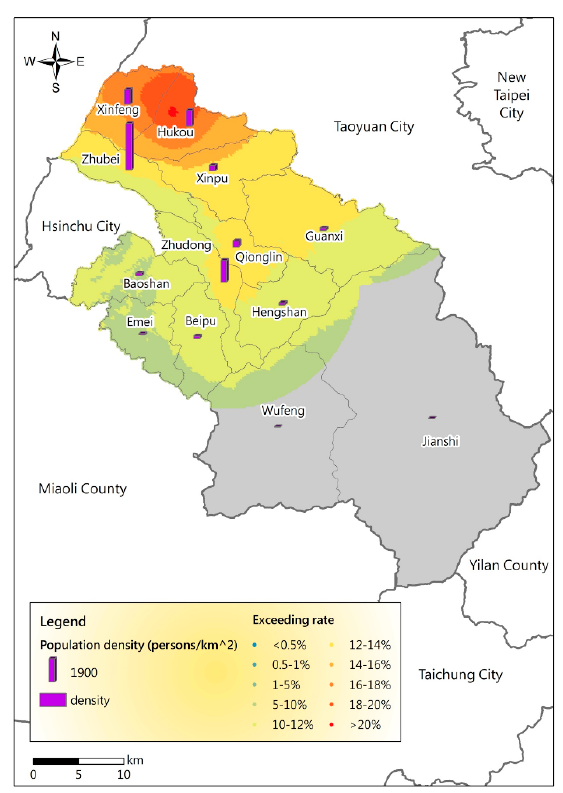
Figure 6. PM 2.5 potential distribution and population density of each township in Hsinchu County.